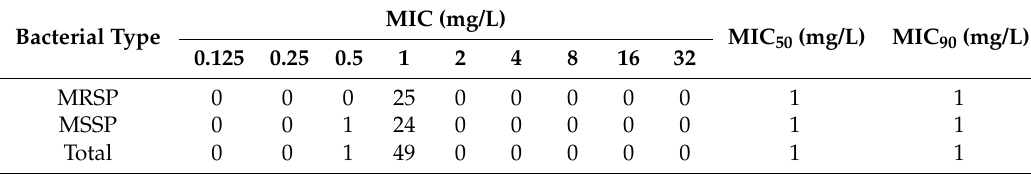
Minimum inhibitory concentrations (MICs) of clotrimazole for 50 Staphylococcus pseudintermedius isolates (25 methicillin-resistant S. pseudintermedius (MRSP), 25